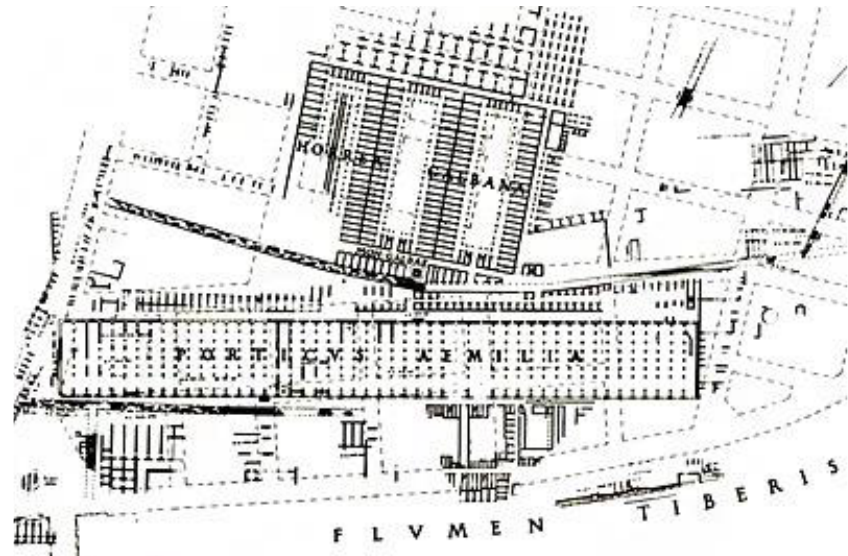
Figure 17. Rome’s southern river port ( Emporium ) with the Porticus Aemilia and the set of horrea Sempronia, Galbana, Lolliana, Seiana, Aniciana [28] (Figure 7).